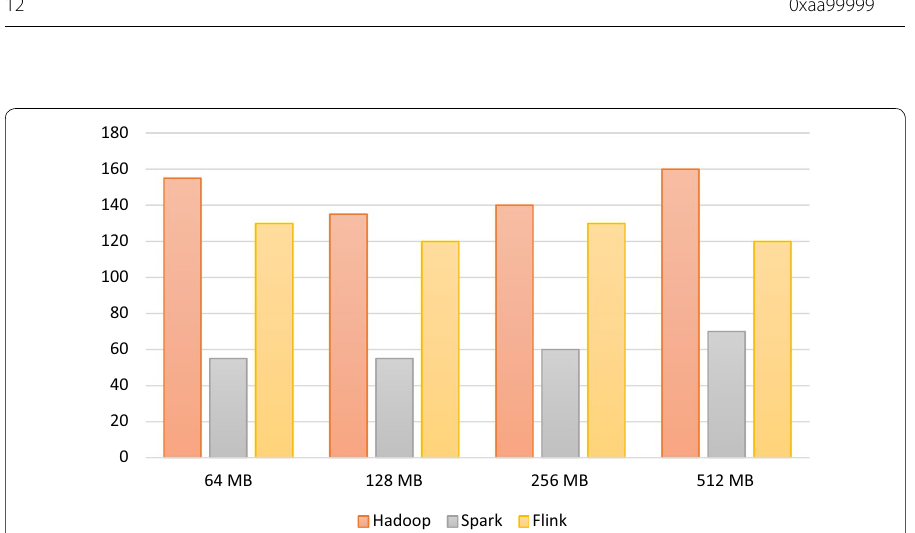
Fig. 9 Execution time (s) for word count program using multiple